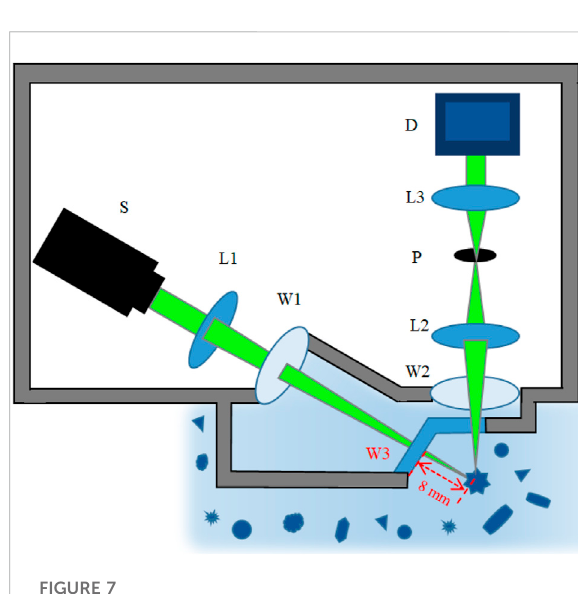
FIGURE 7 New setup with the shielding strategy. W3 is a glass window, and D L becomes 8